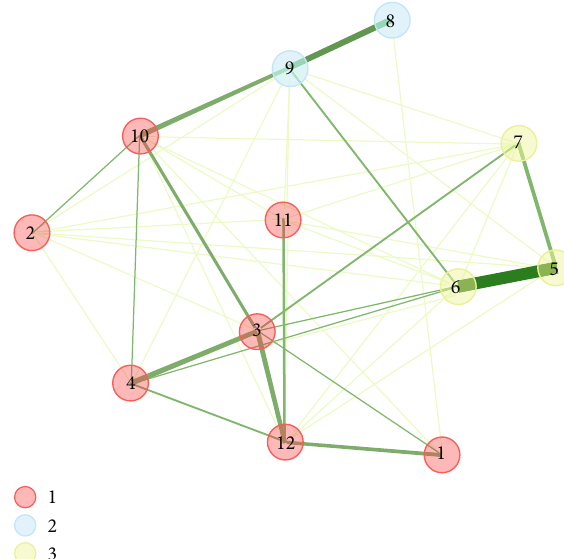
Figure 1: EGA of comorbidity patterns. Note: the greater the intensity of the connection, the greater the positive association. The thickness of the line is equivalent to the magnitude of the ratio. (1) Obesity, (2) cancer, (3) high blood pressure, (4) high blood cholesterol, (5) heart attack, (6) coronary heart disease, (7) stroke, (8) asthma, (9) respiratory diseases, (10) arthritis, (11) kidney disease, and (12)